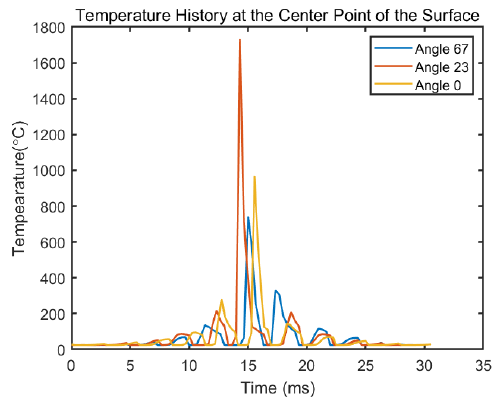
Figure 11. Temperature history of the center point on the fifth layer on a 4 mm 2 square island with and without different rotational angle between layers. The process parameters are laser power 195W, laser scan velocity 800 mm/s, layer thickness 30 μ m, and hatching space 0.17 mm.